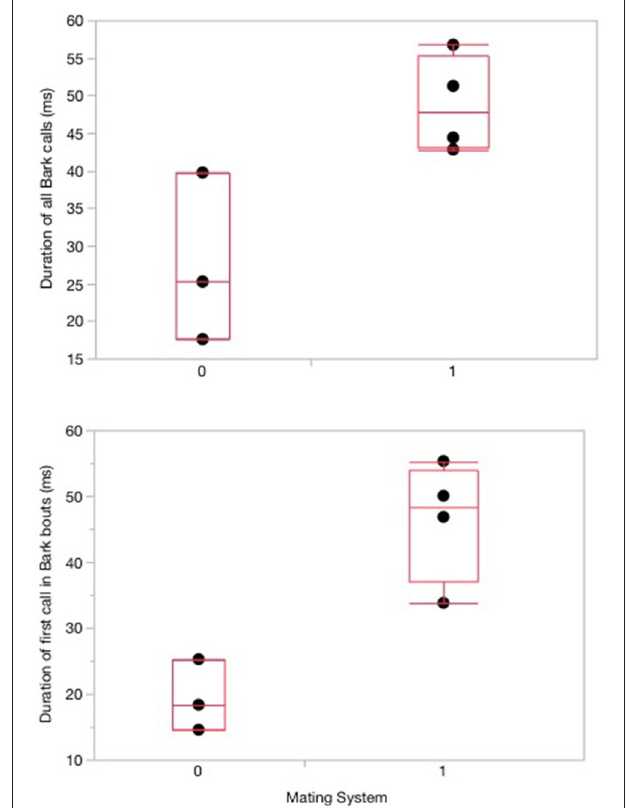
FIGURE 3 | Box and whisker plots with medial values from Wilcoxon signed-ranked test. Significant relationships between predicted mating system and duration of bark USVs recorded from 7 species at the Peromyscus Genetic Stock Center in 2006. Species represented and predicted mating systems for each are in Figure 1